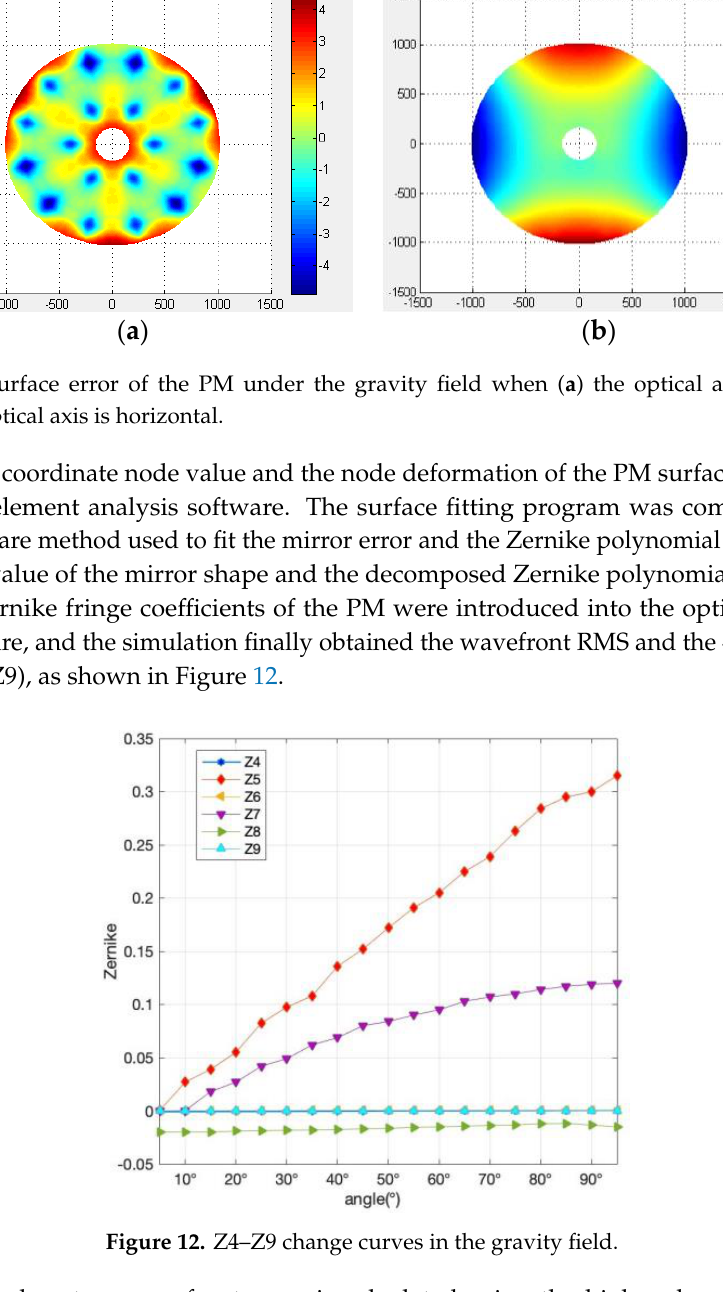
Figure 10. Finite element model of the primary mirror (PM).